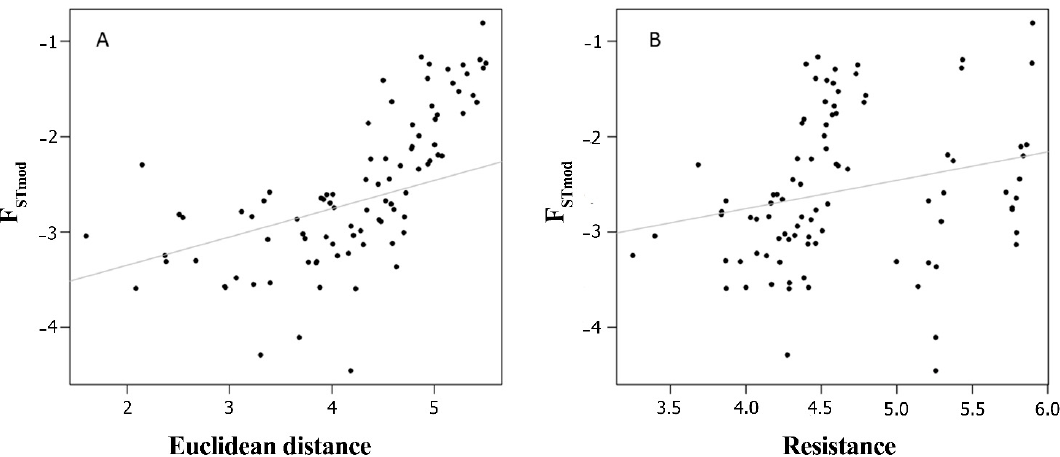
Figure 5. Estimated relationships between genetic differentiation ( F ST mod) and geographic distance (( A ), R 2 = 0.45, p = 0.001) and F ST mod and landscape resistance (( B ), R 2 = 0.1, p = 0.02) for C. yucatanicus in the northern coast of the Yucatan Peninsula, Mexico in the field during surveys from 2015 to 2016. Values correspond to a logarithmic modification of data.